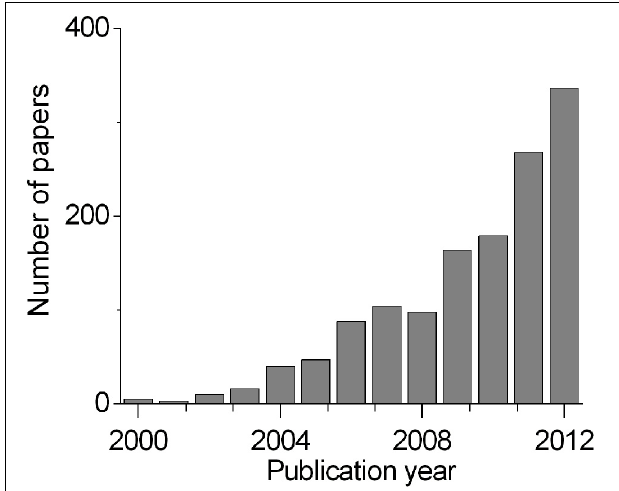
FIGURE 1 | The number of papers published each year with terms “Brain Machine Interface,” PubMed search